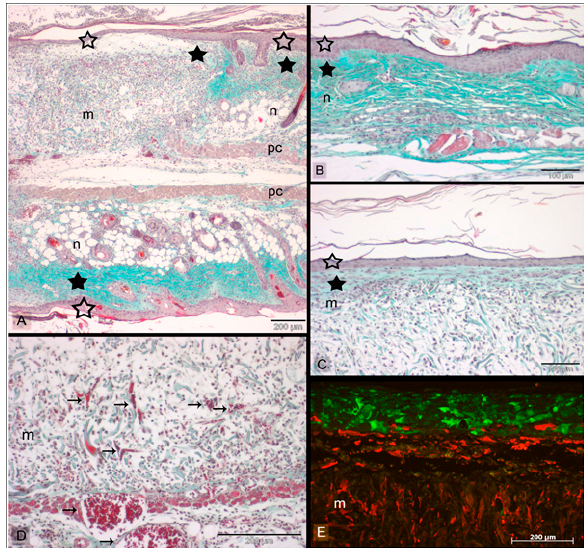
Figure 4. Skin grafts implanted in mice for 11 days in dorsal skin fold chambers. Sections are stained with Masson’s trichrome ( A – D ) and analyzed with fluorescence microscopy ( E ), respectively. ( A ) Shows the junction between the inserted skin graft (m = Matriderm ® ) and host mouse skin (n) at the wound edge after 11 days. The engineered and the intact skin part in the sandwiched skin model are separated by the panniculus carnosus (pc). Both in native mouse skin ( B ) and printed skin graft ( C ) a thick epidermis (empty asterisks) and corneal layer can be seen. In skin graft, the epidermis layer is formed by the printed keratinocytes ( E ) noted by green fluorescence that’s emitted by HaCaT-eGFP cells. The fibroblasts (NIH3T3 cells-mCherry) is seen partly migrating into the Matriderm ® (yellowish fibres). The fibroblasts that remains on top of the Matriderm ® , exhibits an outstretched morphology ( C ), along with collagen deposition (filled asterisks). Blood vessels (arrows) can be noticed in the skin constructs ( D ). Scale bars depict 200 µm ( A , D , E ) and 100 µm ( B , C ) (Reprinted under open access distribution license from